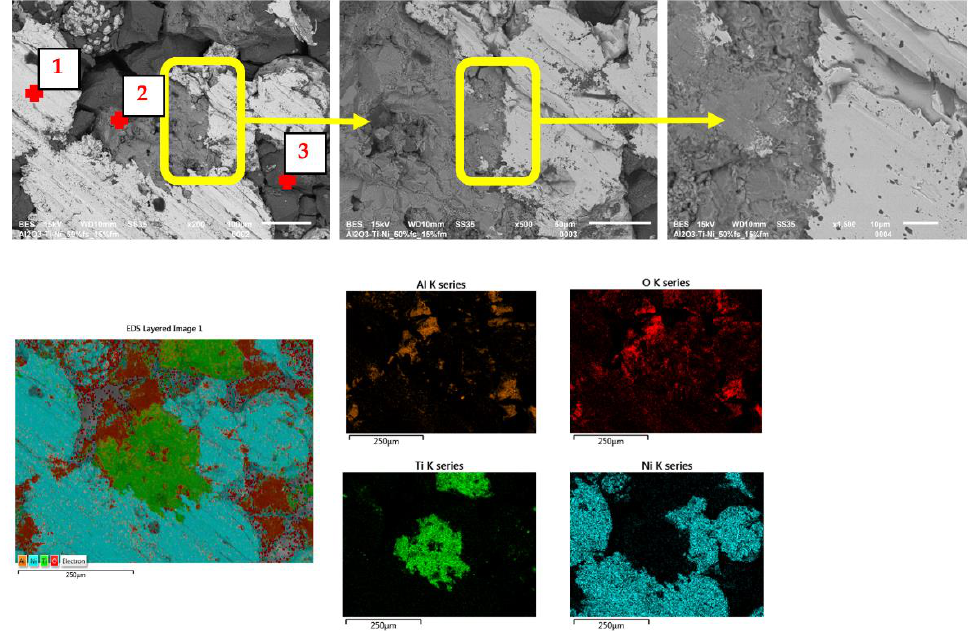
Figure 10. SEM/EDS results of samples with 10% volume of the metallic phase.